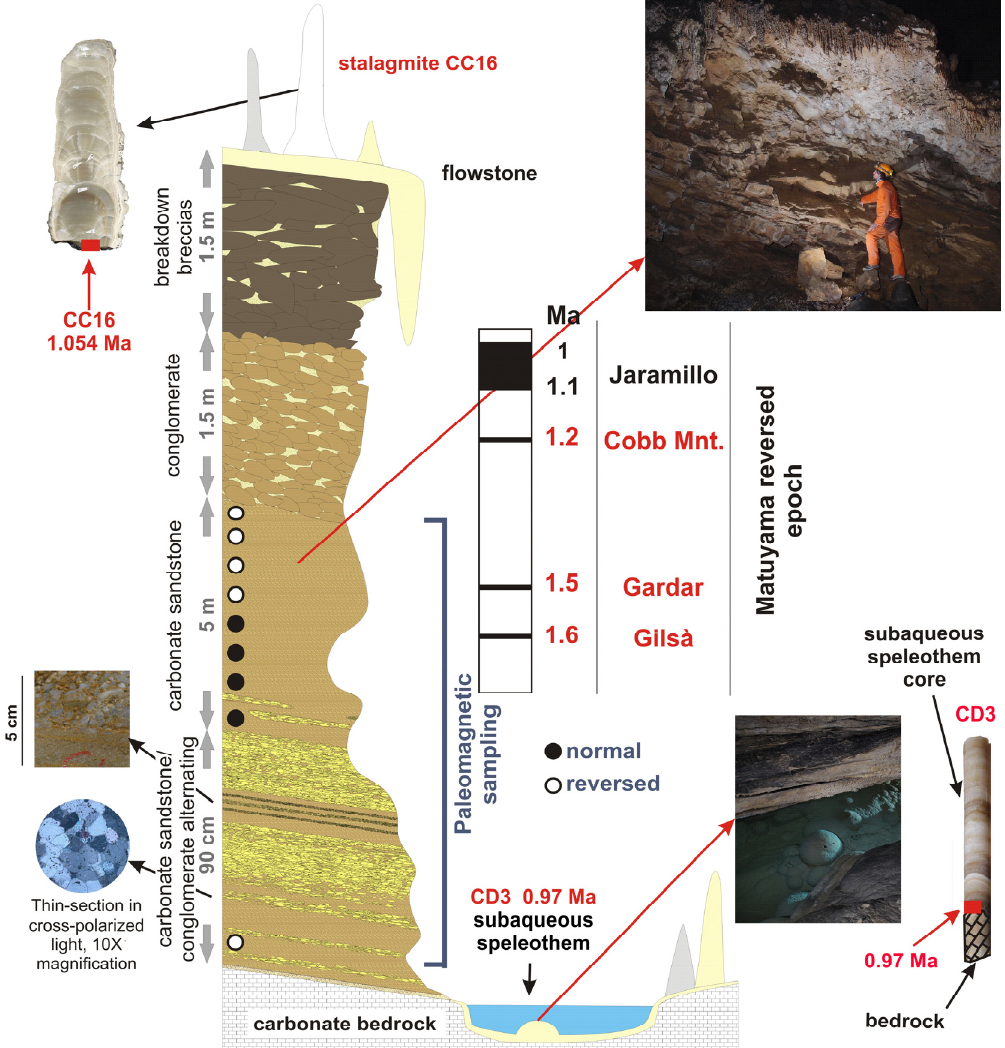
Figure 2. Stratigraphic column of the studied fluvial section and its relationship with speleothems. Vertical axes are not at scale, and the layer thickness is expressed by gray arrows. At thin-section scale, the conglomerate has a fine carbonate matrix and sub-rounded clasts consisting of mineral grains (calcite, quartz, mica, feldspar, and epidote), sandstone, and metamorphic rocks. Sandstone clasts vary from medium to very fine in size and are well sorted and sub-rounded. They comprise minerals (calcite, quartz, mica, chlo- rite, feldspar, and oxides) and metamorphic and siliciclastic lithic components.